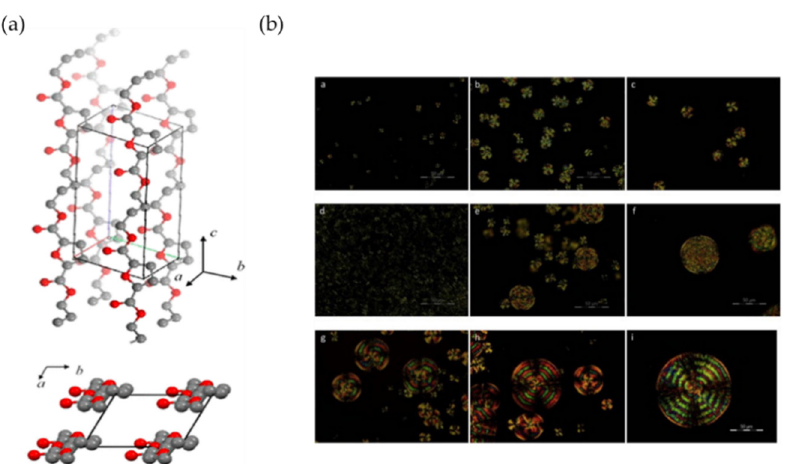
Figure 4. ( a ) Views of the PBF structure [21] ; ( b ) PLM images of spherulites of (a) PPF grown at 130 °C, (b) PPF grown at 135 °C, (c) PPF grown at 145 °C, (d) PPN grown at 165 °C, (e) PPN grown at 175 °C, (f) PPN grown at 190 °C, (g) PPT grown at 208 °C, (h) PPT grown at 212 °C, (i) PPT grown at 214 °C with a scale bar of 50 μ m [41] .